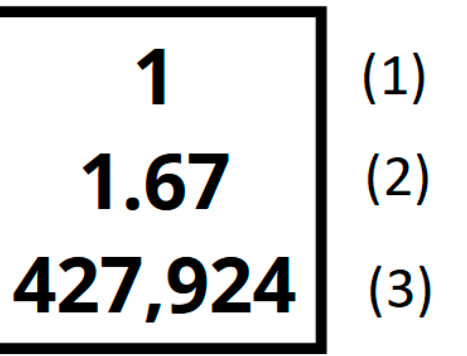
Figure 1. The description of the root node, including the node ID (1), milking efficiency (2) and number of observations in a node or a leaf (3).